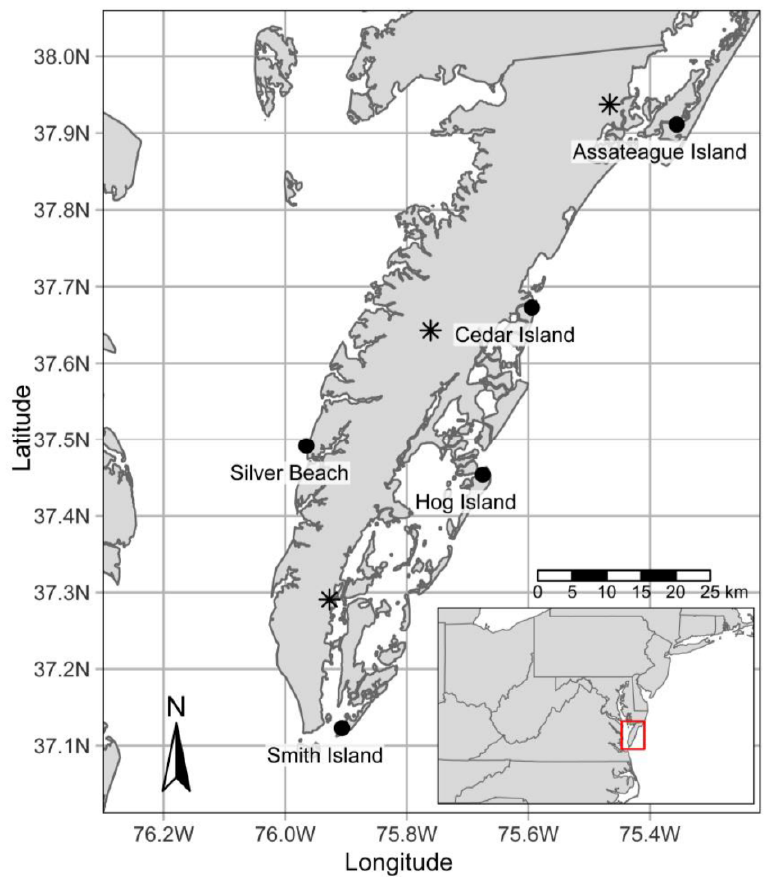
Figure 1. Acoustic detector sites (black points) on barrier islands and a light tower off the Eastern Shore of Virginia, USA, 2012–2019. Weather data was obtained from the nearest available National Oceanic and Atmospheric Administration (NOAA) weather stations (starred points) from the Na- tional Climatic Data Center (NCDC) online tool (Climate data online; https://www.ncdc.noaa.gov/ cdo-web/; accessed on 9 November